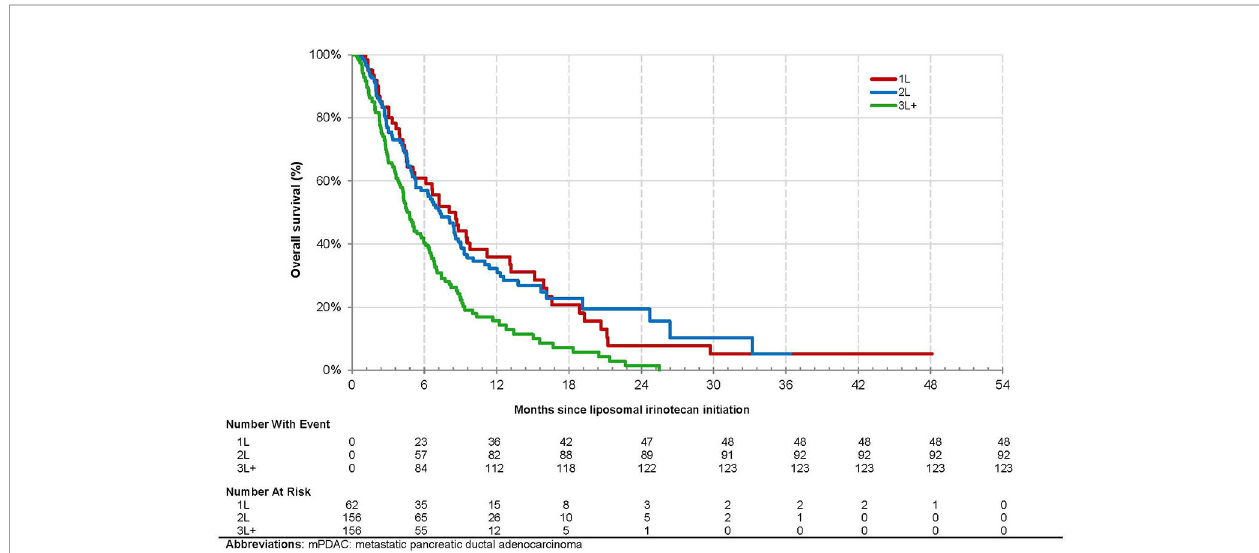
FIGURE 3 | Kaplan-Meier Analysis of Overall Survival from Initiation of Treatment with Liposomal Irinotecan among Patients with mPDAC Treated with Liposomal Irinotecan in a Doublet with